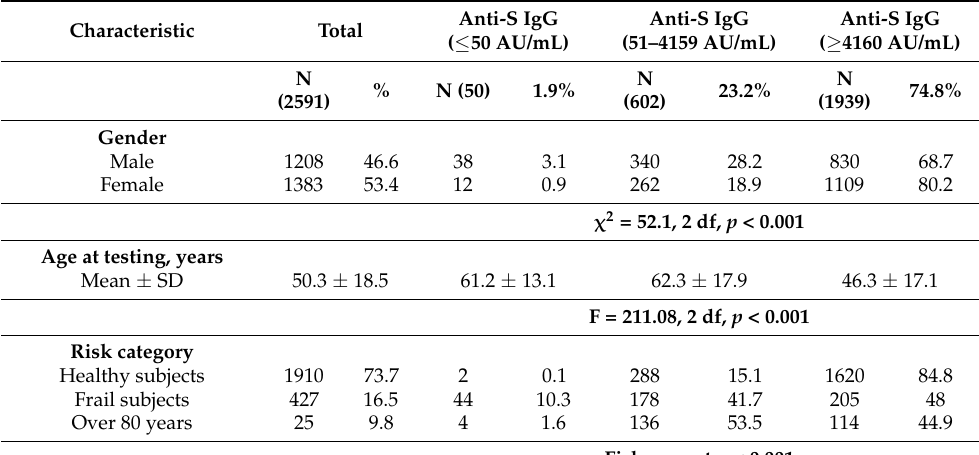
Table 1. Characteristics of subjects tested 30 days after full course of vaccination stratified by anti- SARS-CoV-2